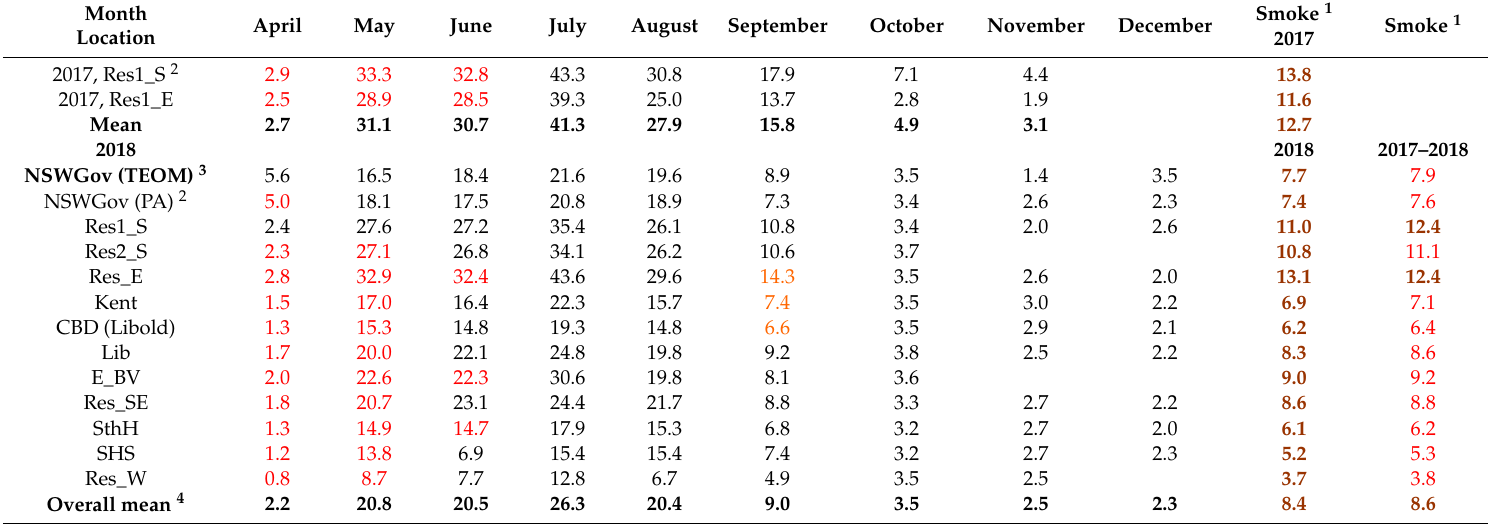
Table 3. PM 2.5 measurements at various locations (shown in Figure 1) in Armidale (estimated values in